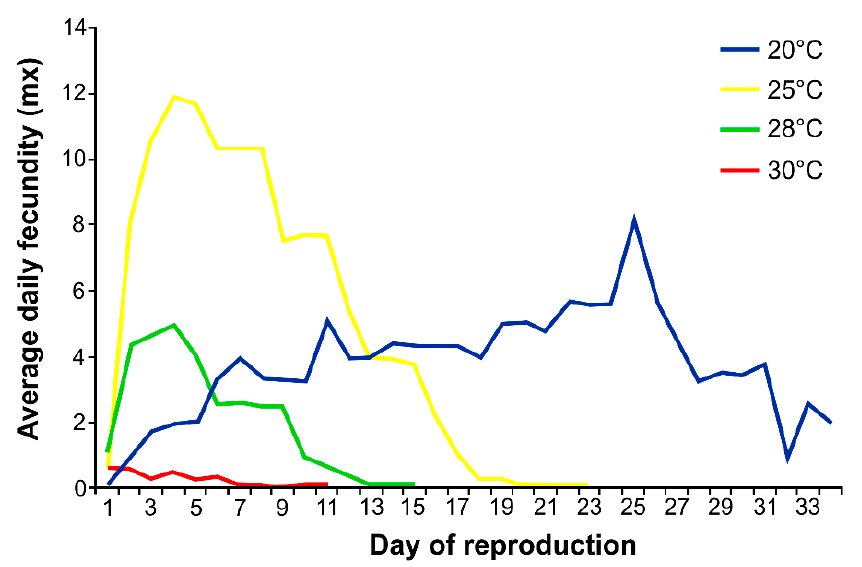
Figure 2. Number of nymphs produced (fecundity) daily by apterous Phorodon cannabis at different temperatures ( n = 50).